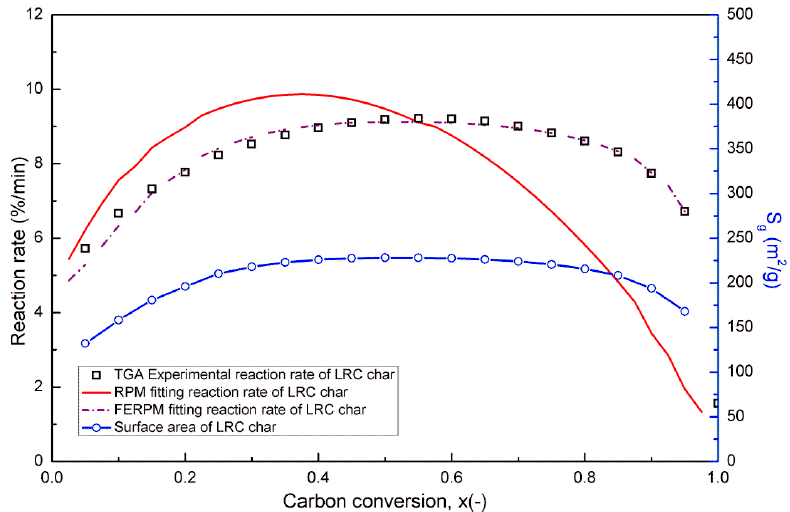
Figure 3. Char oxidation reaction rates and surface areas ( S g ) for the carbon conversion of low-rank coal char as calculated by the random pore model (RPM) and Flexibility-Enhanced Random Pore Model (FERPM) using thermogravimetric analyzer (TGA) apparatus.